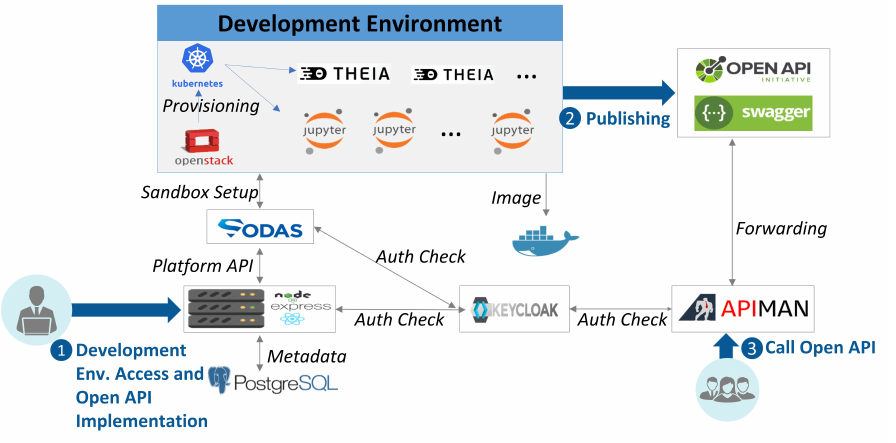
Figure 10. Operational structure of ADE